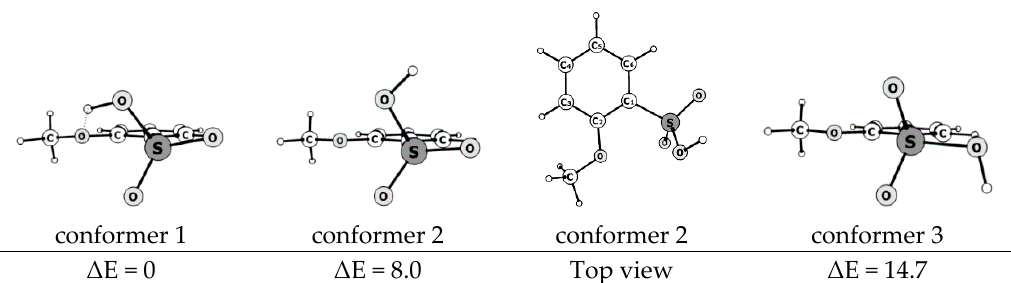
Figure 6. The structure of the 2-CH 3 -BSA conformers and their relative energies ( Δ E, kJ mol − 1 ).